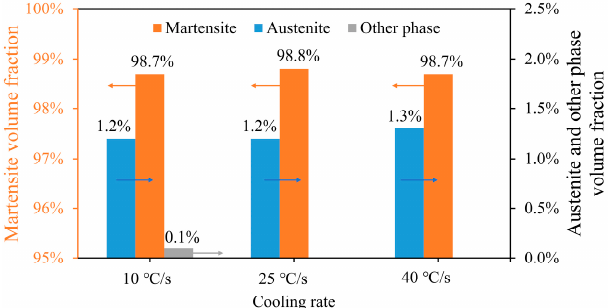
ff erent cooling